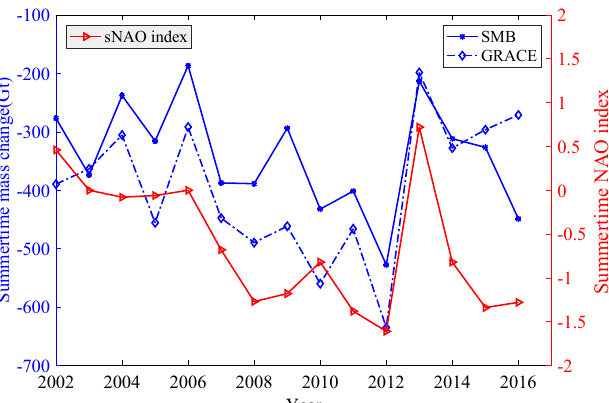
Figure 8. The summertime mass changes in GrIS from GRACE and SMB-D and summertime North Atlantic oscillation (NAO) index.